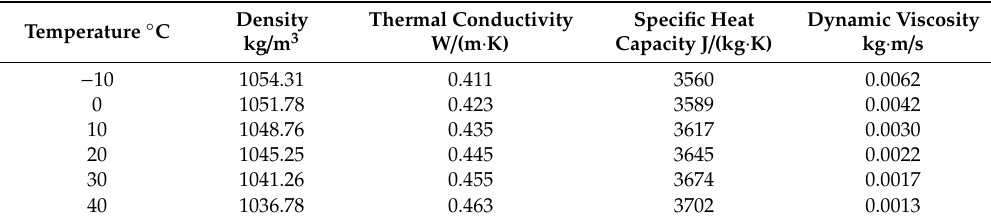
Table 1. Physical properties of the ethylene glycol [13].